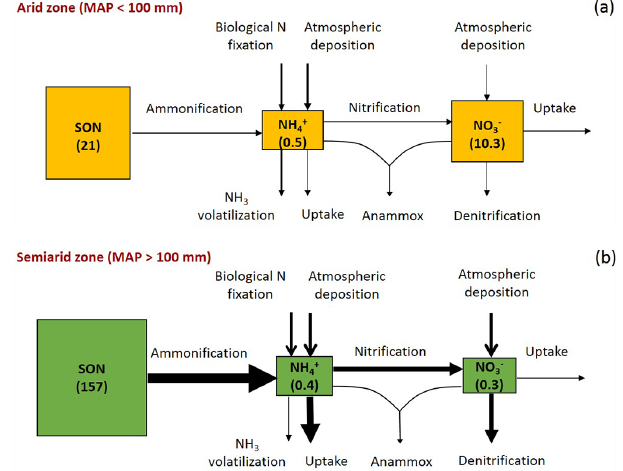
Figure 8. A framework of N biogeochemical cycling in dry- land ecosystems in northern China. Width of arrows and size of boxes indicate the relative importance (qualitative interpretation) of soil N processes and pools between the arid zone (a) and semiarid zone (b) . The mean pool sizes (g Nm − 2 ) of each soil N pool based on the bulk soil density of the top 10cm are in the brackets. It should be noted that during both nitrification and denitrification, N trace gases NO and N 2 O can be produced and escape the system (leaky pipe model (Firestone and Davidson, 1989), not shown in the fig- ure), affecting both NH + and NO − concentrations and their δ 15 N 4 3